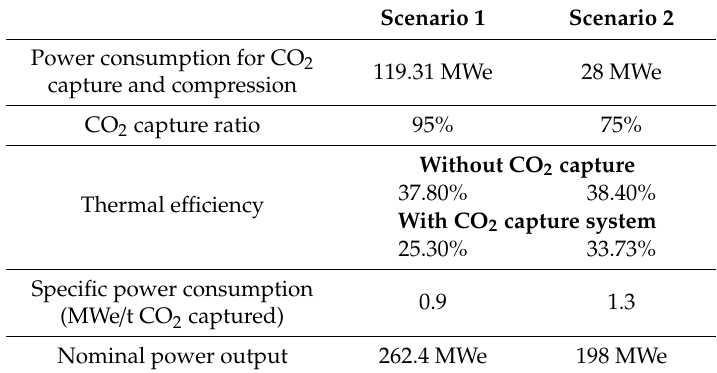
Table 5. Di ff erences in significant technological parameters of both